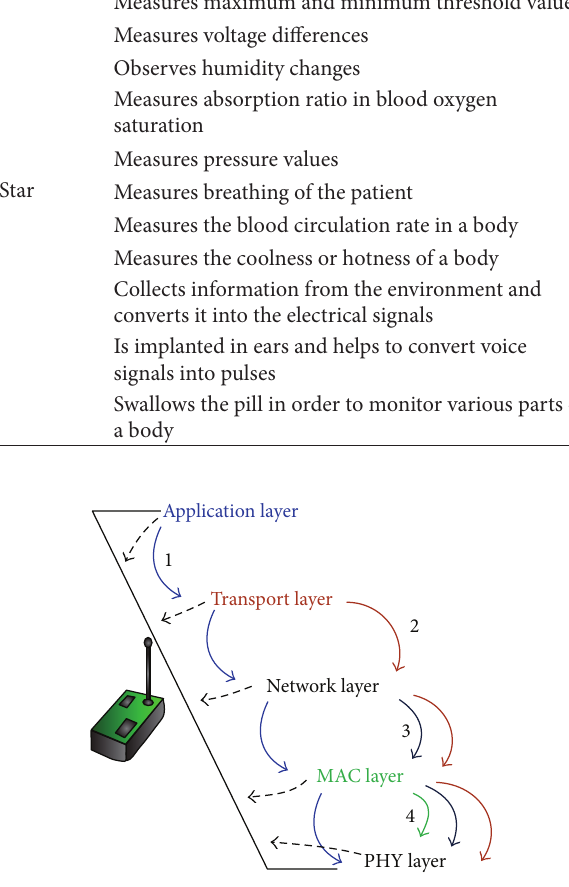
Figure 2: Nonmanager method for information sharing (redrawn from [14,